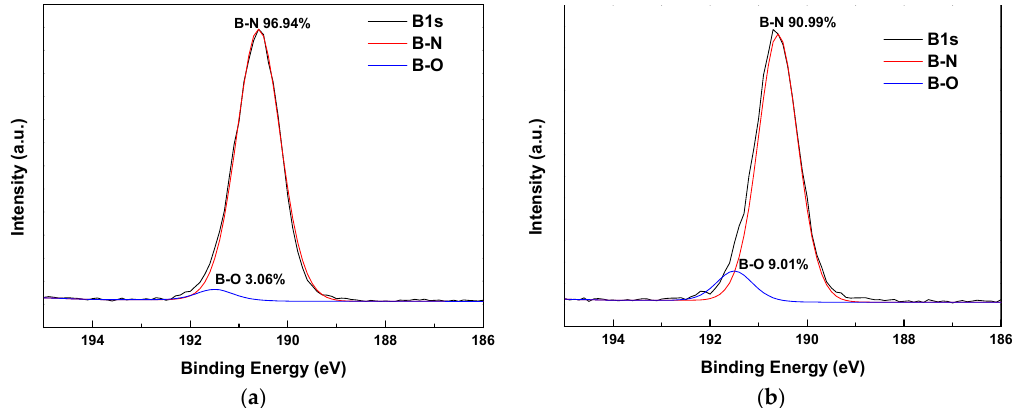
Figure 6. XPS survey spectra of pristine BNNSs and plasma modified BNNSs.